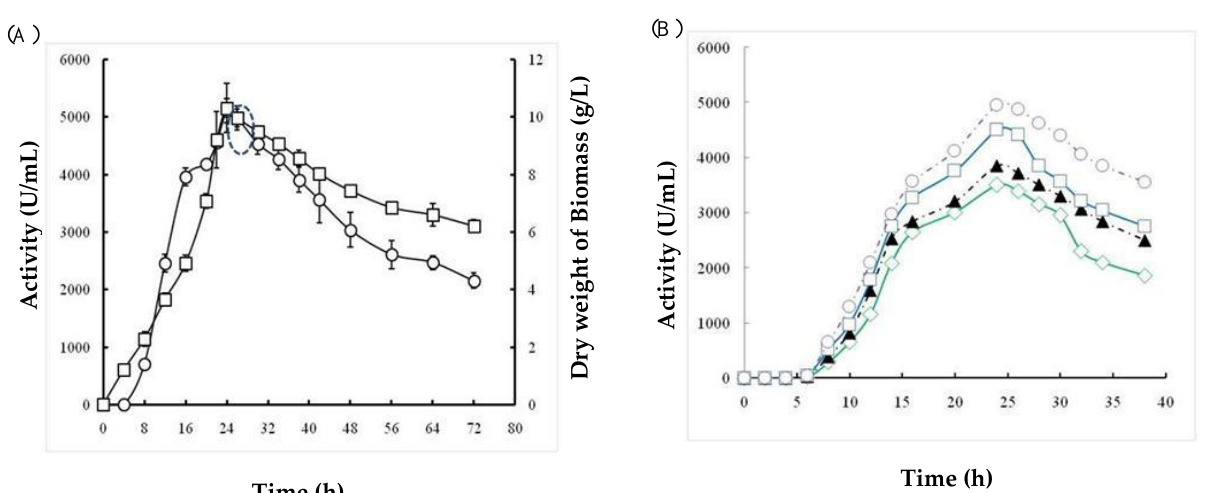
Figure 4. Effect of incubation time ( A ) on growth (white squares) and protease activity (white circles) and effect of inoculum size ( B ) on protease activity; (green line; 10 8 CFU/mL) (black line; 2 × 10 8 CFU/mL) (blue line; 4 × 10 8 CFU/mL) (purple line; 8 × 10 8 CFU/mL).